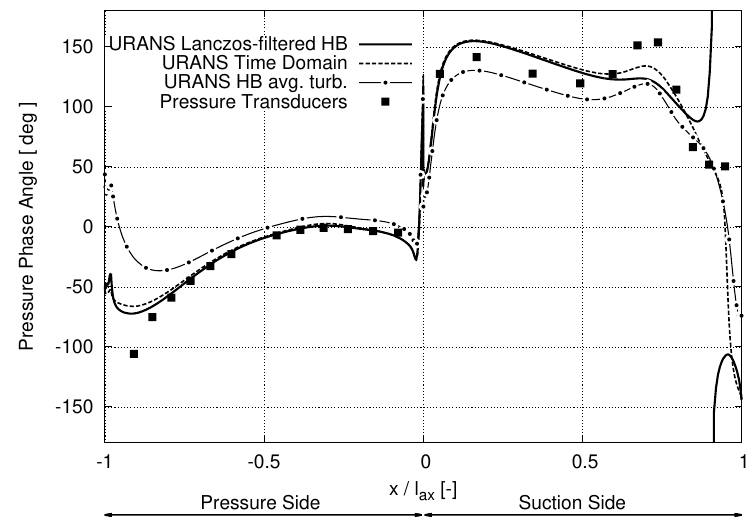
Figure 8. Pressure fluctuation phase angle at WGPF along the axial chord length l ax of the excited LPT stator cascade.